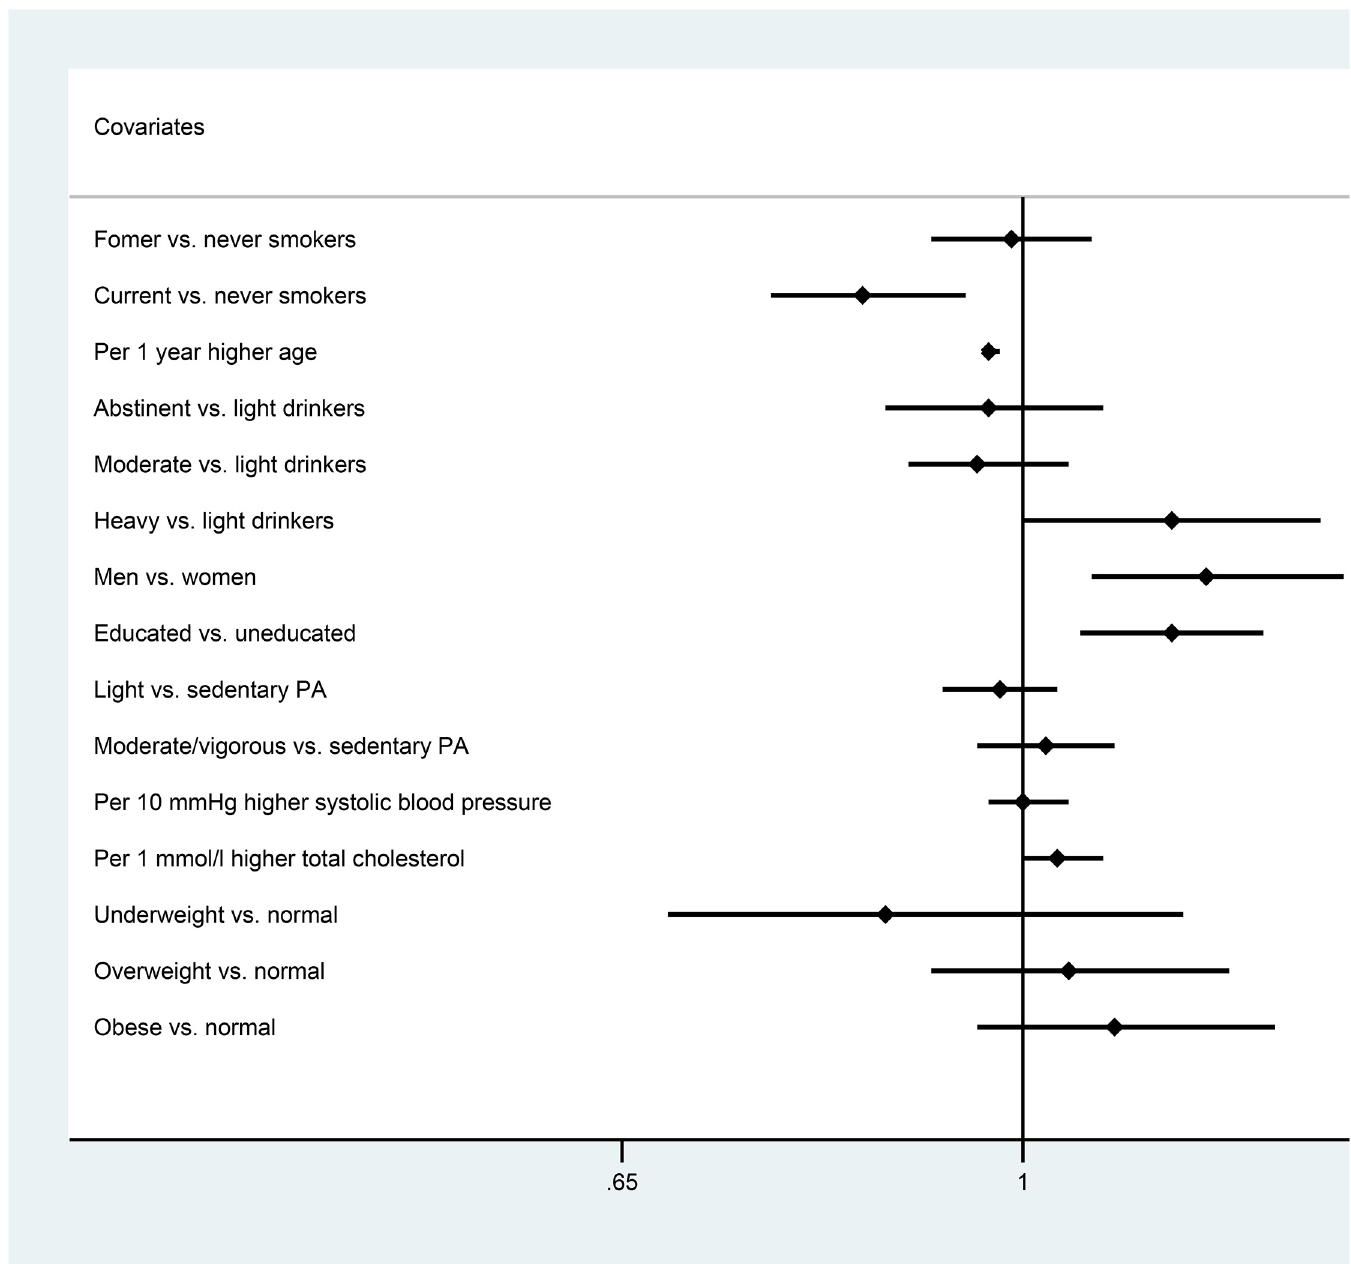
Fig 1. Overview of the results of meta-analyses of the study-specific estimates of the associations of atopy with possible lifestyle-related factors. Abbreviations: OR, odds ratio; CI, confidence interval; vs., versus.